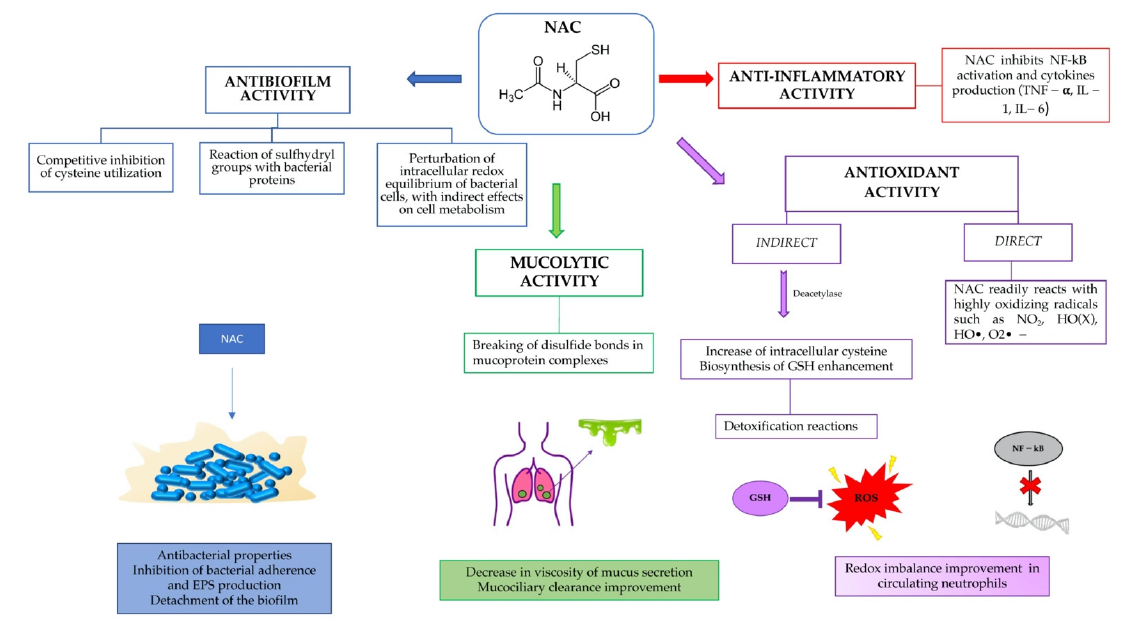
Figure 1. Summary of NAC activity in cystic fibrosis patients.